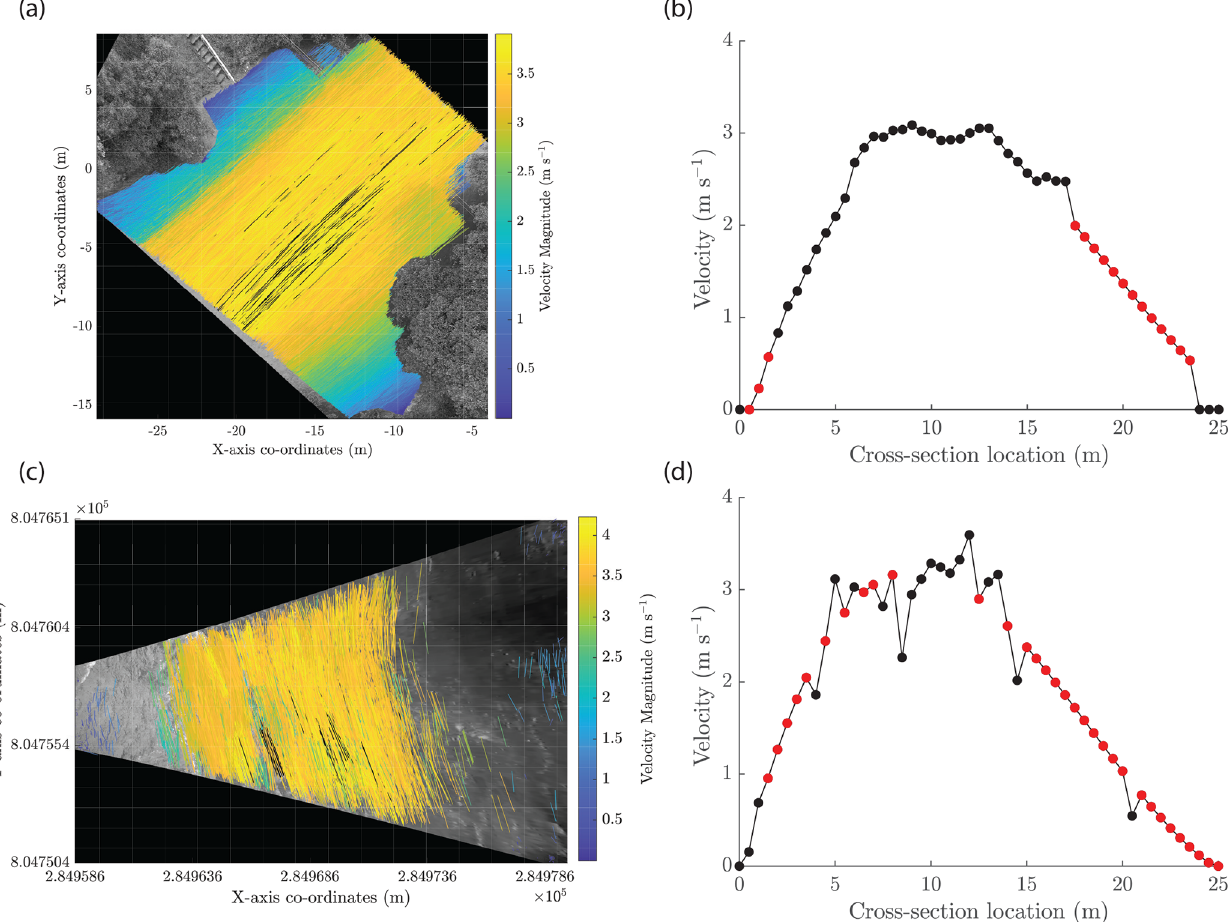
Figure 5. KLT-IV example outputs for the river Feshie at a river stage of 1.762m using a DJI Phantom 4 Pro unmanned aerial system (UAS) (a, b) and a fixed Hikvision camera (c, d) . The reconstructed discharge was 82.11 and 85.38m 3 s − 1 for the UAS and fixed platform respectively. Panels (a) and (c) illustrate the trajectories and displacement rates of objects tracked on the river surface. Features were tracked for a period of 1 and 0.5s for (a) and (c) respectively. Panels (b) and (d) illustrate the depth-averaged velocity for the river cross section. Black points indicate observations whereas red points indicate nodes of